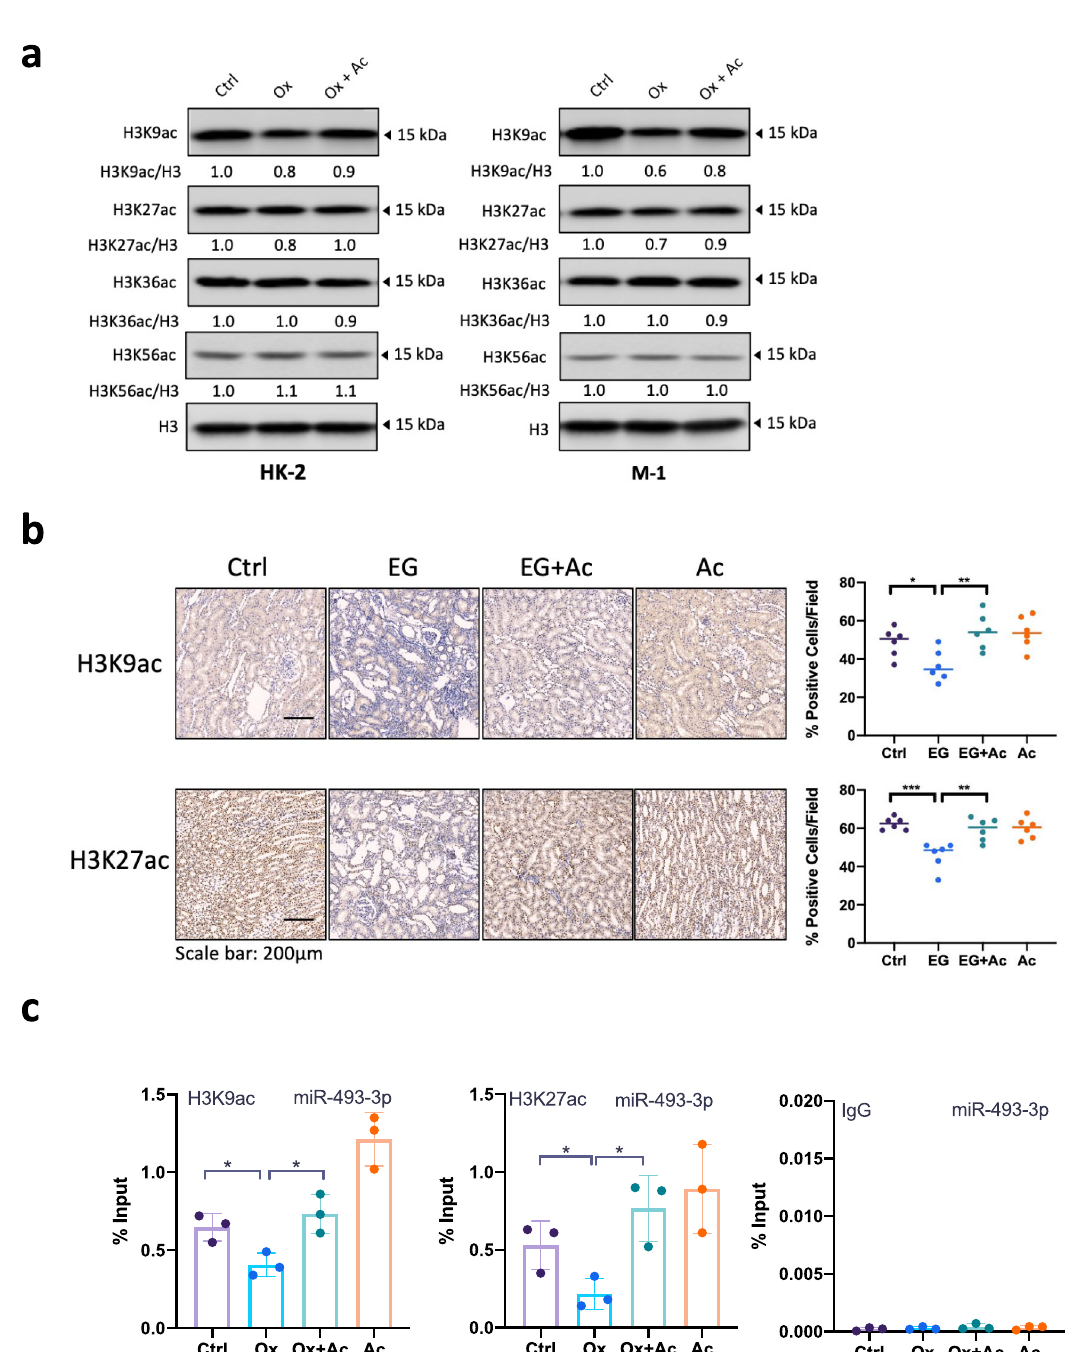
Fig. 5 Acetate activated miR-493-3p through epigenetic regulation. a Acetate rescued hyper-oxalate-reduced H3K9 and H3K27 acetylation levels. HK-2 or M-1 cells were treated with or without 2 mM sodium acetate under hyper-oxalate condition (0.5 mM) for 24 h. The histone acetylation levels were determined by Western blot. Total H3 served as a loading control. b IHC staining of H3K9ac and H3K27ac in kidney tissues from each group rats (ampli fi cation × 200). n = 6 for each group. c ChIP-qPCR assays showing histone acetylation enrich at miR-493-3p promoter region in HK-2 cells treated with or without 2 mM sodium acetate under normal or hyper-oxalate condition (0.5 mM) for 24 h. Rabbit IgG was included as negative control. For ( b ), quantitations are at the right. Ctrl, control. EG, ethylene glycol. Ac, acetate. Ox, oxalate. n.s, not signi fi cant, * P < 0.05, ** P < 0.01,*** P <